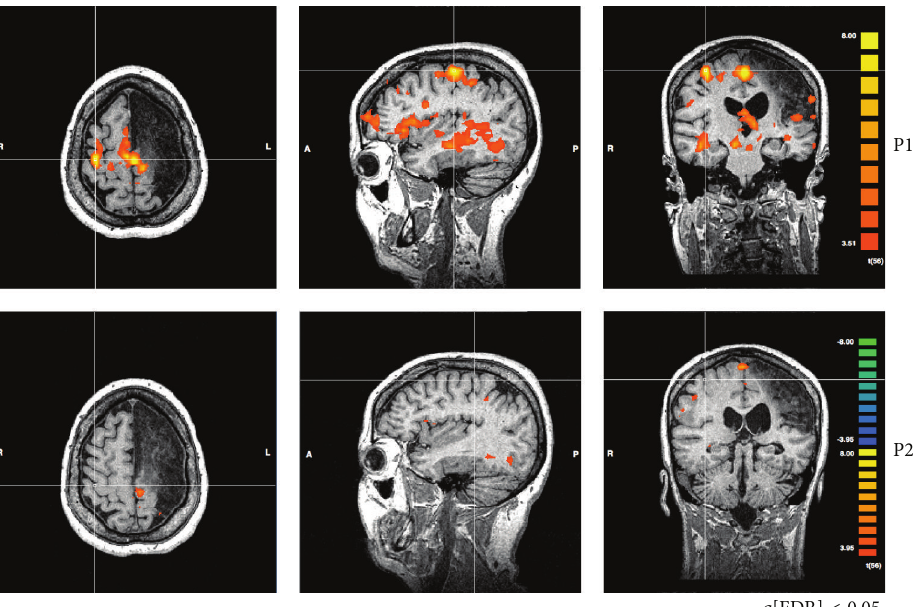
Figure 3: fMRI of patient #3 showing changes from contralesional M1 (at P1) to ipsilesional M1 (at P2). Before rehabilitation (P1), there is an increased activity of M1 in the contralesional hemisphere (ipsilateral to the moving hand) and of SMA. Right after rehabilitation, the activities of both areas are reduced.